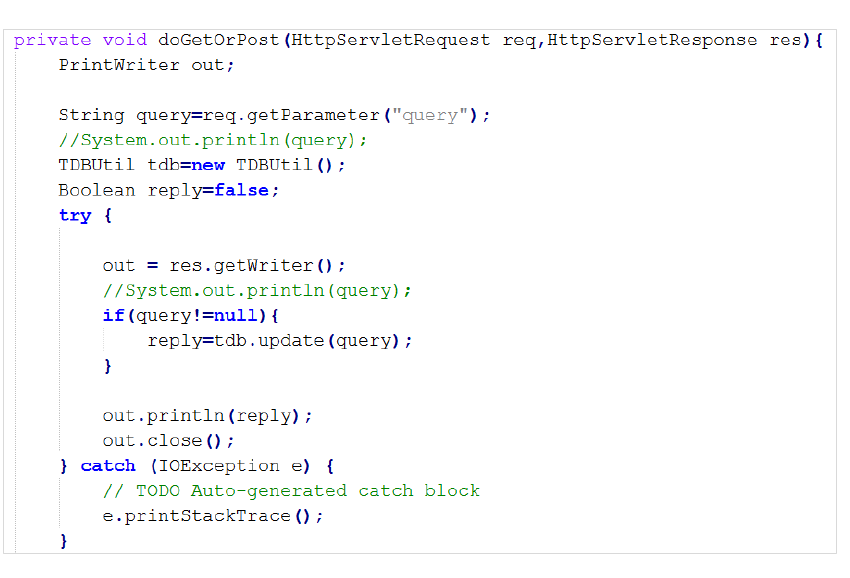
Figure 19. UpdateExec API for updating